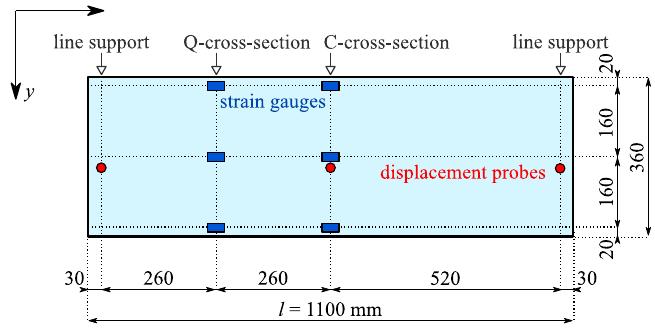
Fig. 2 Experimental setup for bending analysis of laminated glass